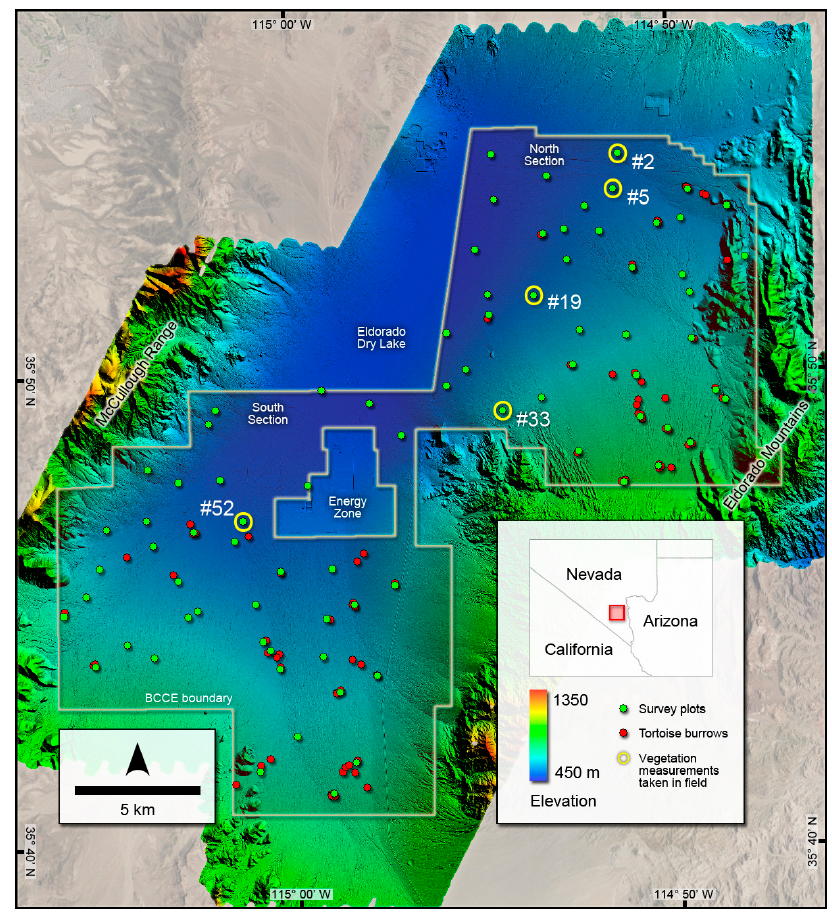
Figure 1. Survey area superimposed on elevation (shown in color). The BCCE is shown in the gray outline; green dots are line transect survey plots; red dots are observed tortoise burrows; and yellow circles represent the location of designated plots for field vegetation measurements. Numbers refer to calibration plots used in the study.